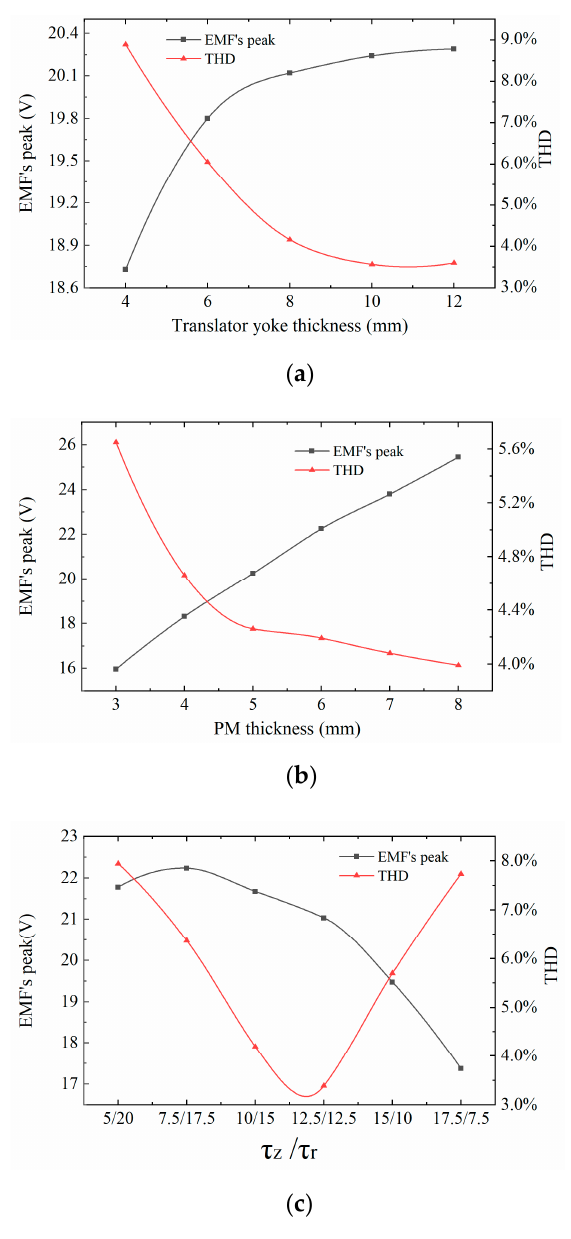
Figure 5. Effect of translator on EMF. ( a ) Translator yoke thickness. ( b ) PM thickness. ( c ) τ z / τ r .